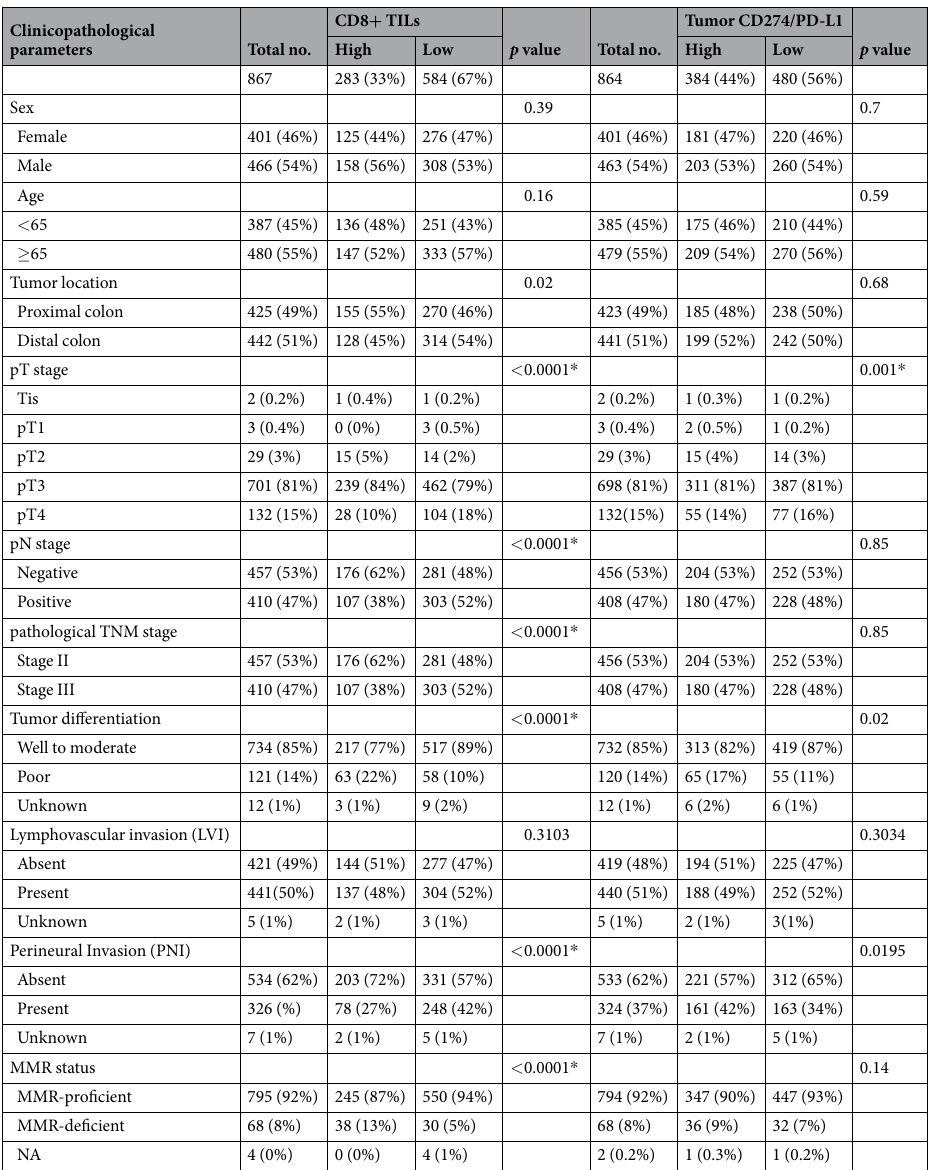
Table 1. Tumor Characteristics and immune status in stage II-III colon carcinoma patient. NA: not available. Fisher’s exact test was used when > 25% of the cells have expected counts less than 5. The Pearson’s chi- square and Fisher’s exact test did not include the “NA” and “unknown” group. * p < 0.005 is significant and 0.005 < p < 0.05 is suggestive